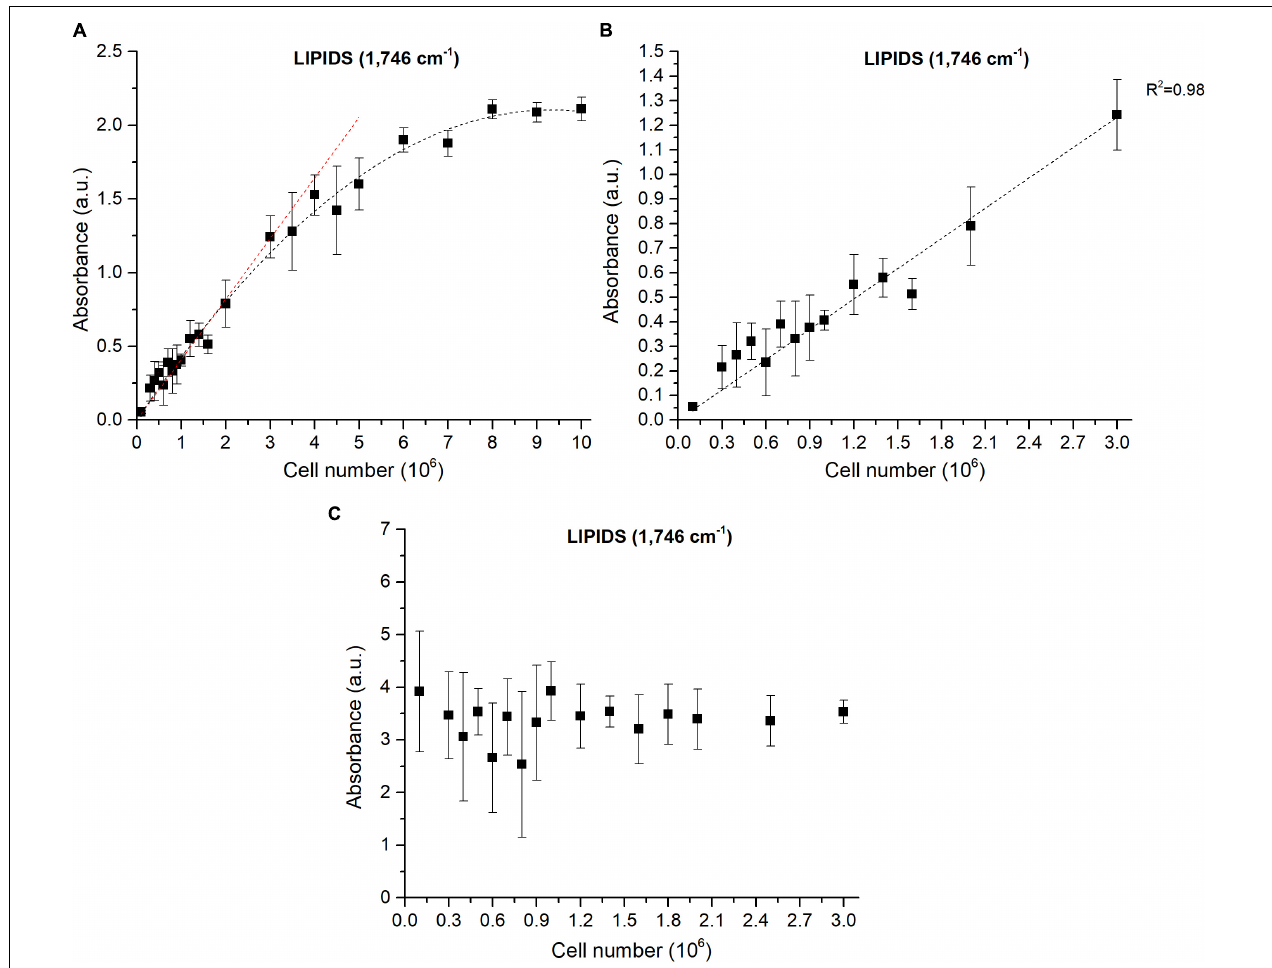
FIGURE 2 | Correlations between FTIR absorbance measured at 1,746 cm − 1 and the number of cells deposited on the silica plate (A) Baseline-corrected spectra considering 0 to 10 million cells, (B) Baseline-corrected spectra considering 0 to 3 million cells, (C) Baseline-corrected and normalized spectra considering 0 to 3 million cells. The coefficient of determination (R 2 ) of the linear regression curve is